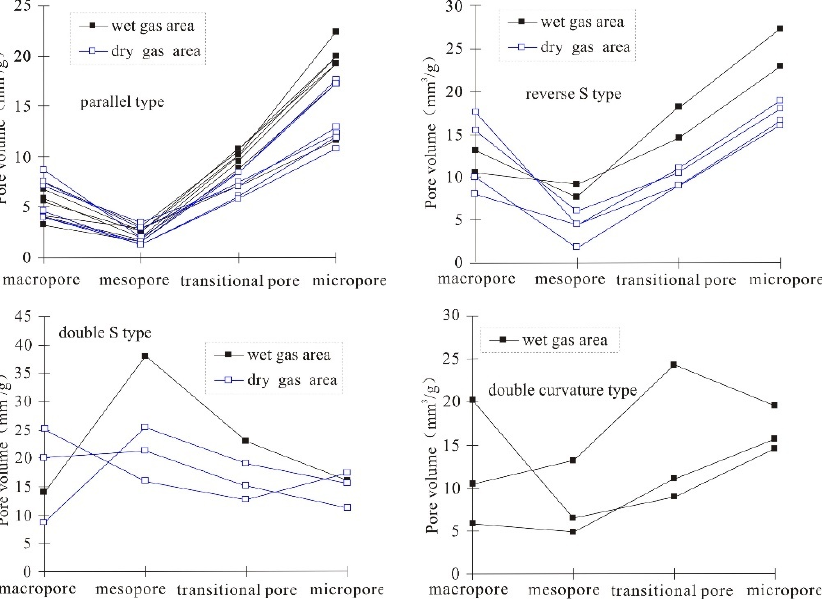
Figure 10. Plots of pore volumes to pore structure of four types of pore structure